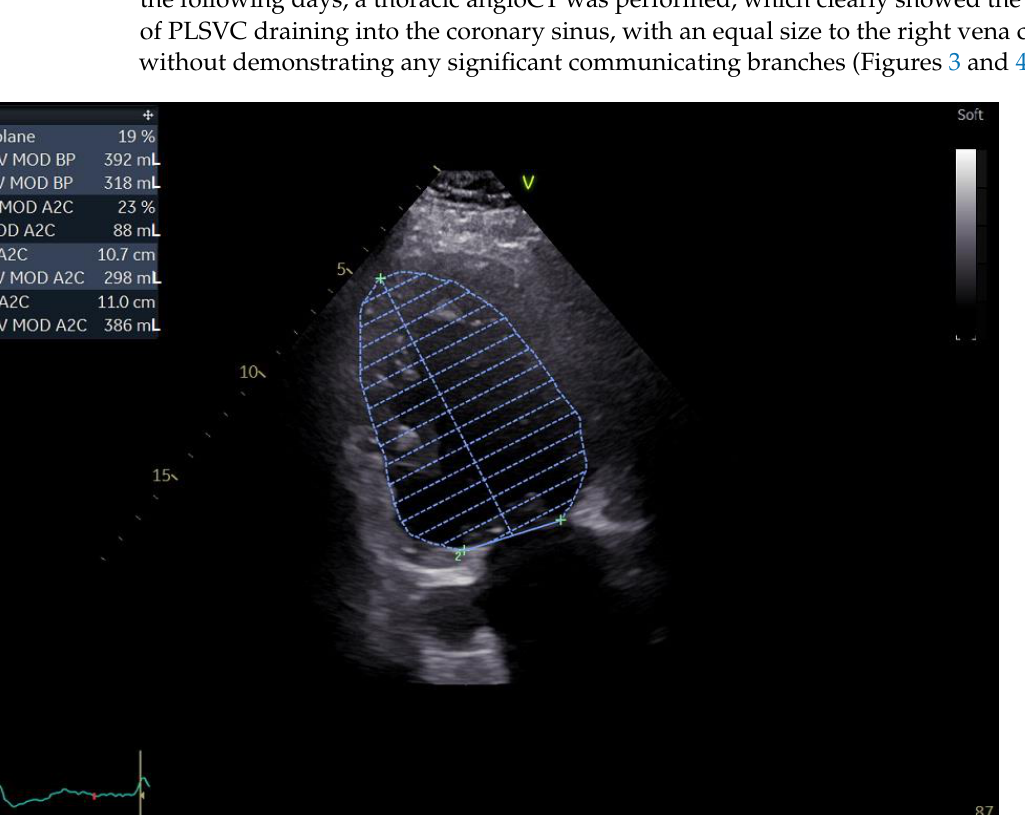
Figure 2. Parasternal long-axis view showing the measurements of the coronary sinus (blue arrow). In this situation, we highly suspected a venous anomaly and the most probable anomaly was PLSVC. The patient was a clear candidate for CRT-D, with a class IIA indi- cation according to the current guidelines [1]. Thus, the following step was the